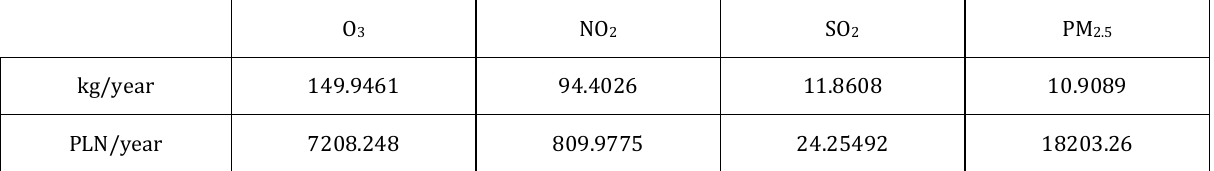
Table 3. Annual air pollution removal - comparison with other